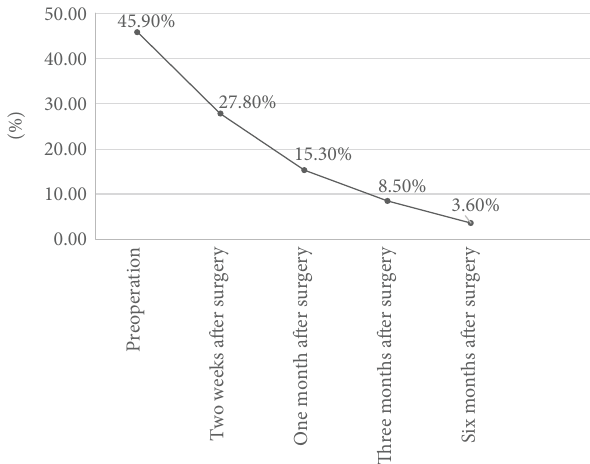
Figure 1: Changes in serum FSVs before and after the Kasai procedure in patients with BA. The proportions of patients with a de fi ciency in vitamins A, D, and E or one or more vitamins were 27.8%, 15.3%, 8.5%, and 3.6% at 2 weeks and 1, 3, and 6 months after surgery, respectively, showing signi fi cant improvement in the percentage of patients with one or more vitamin de fi ciencies (preoperative value, 45.9%; P < 0 0001